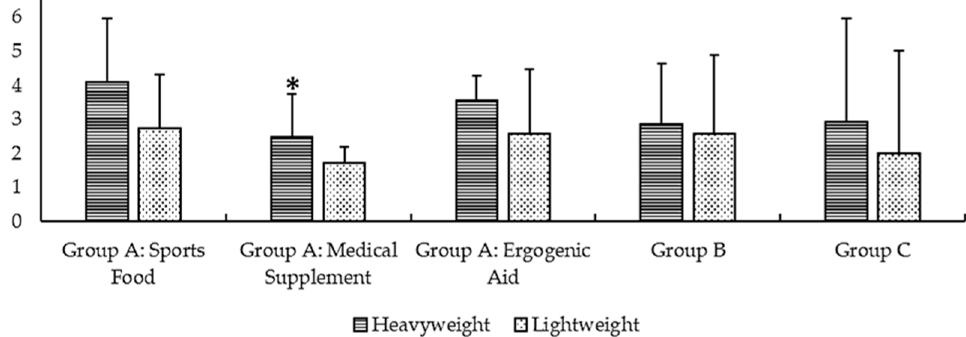
Figure 1. Number of supplements consumed in each category established by the Australian Institute of Sport (AIS) [20] by heavyweight and lightweight rowers. * Statistically significant differences between groups ( p < 0.05).